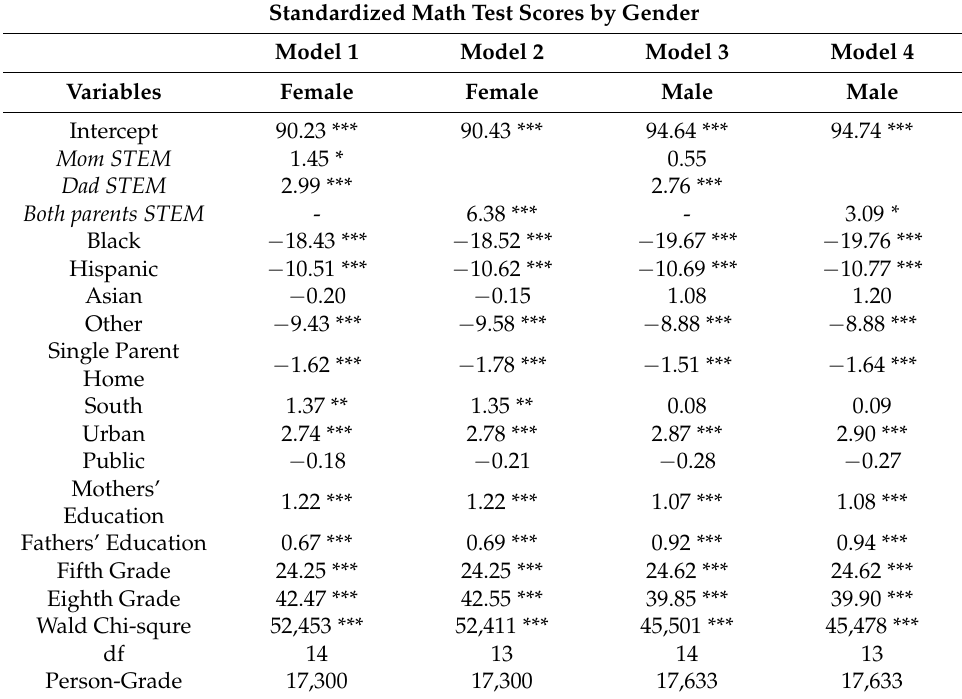
Table 3. Random effects models to predict standardized math scores by